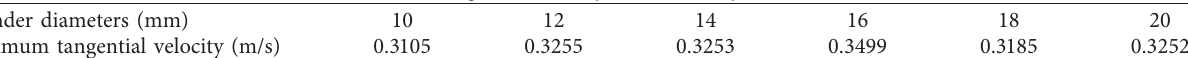
3 section at different cylinder diameters. (a) Absolute radial quantity. (b) Radial Table 2: Maximum tangential velocity at different cylinder diameters.